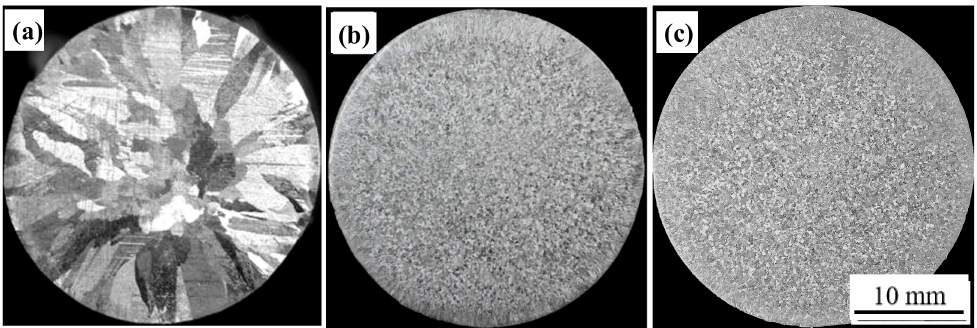
Figure 3. XRD pattern and SEM image of Al-5Ti-0.62C master alloy: ( a ) XRD pattern; ( b ) SEM image.